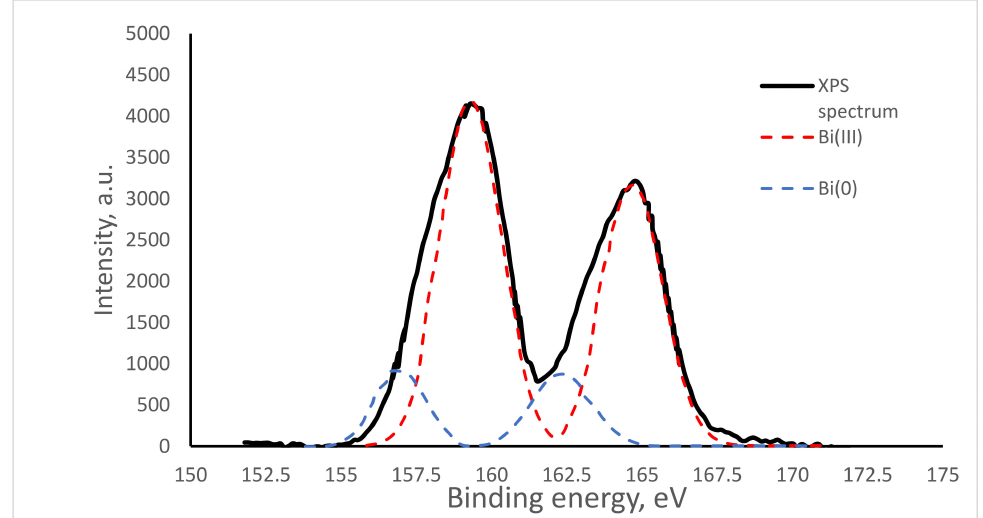
Figure 5. XPS spectrum of sample